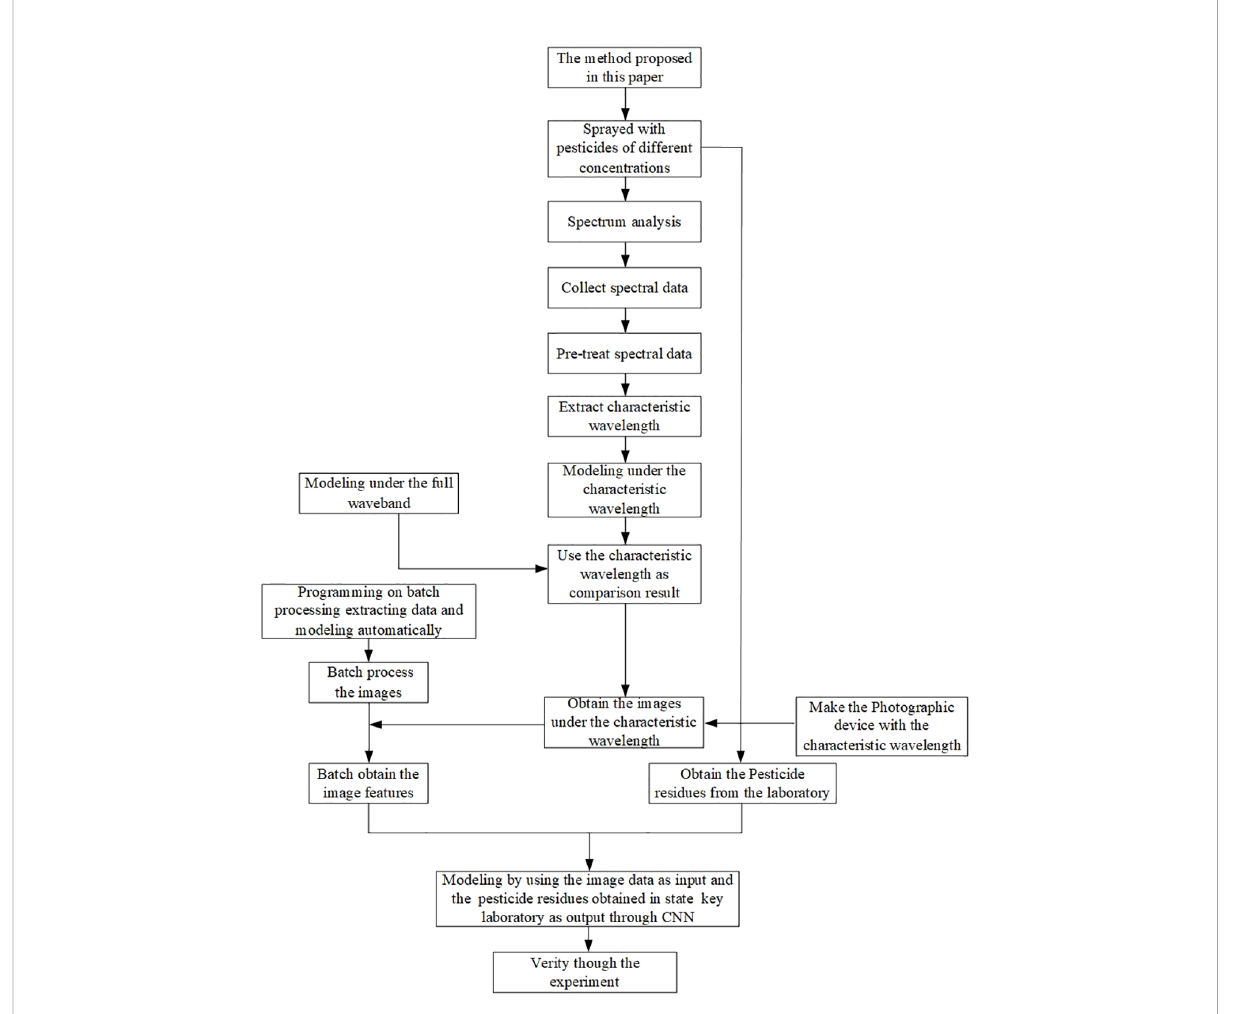
FIGURE 9 Flow chart of the method proposed in this